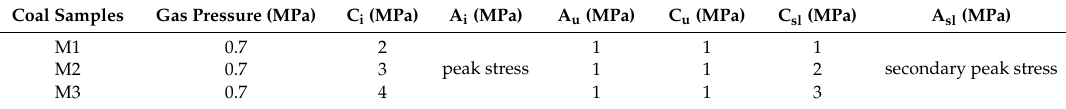
Table 1. Experimental